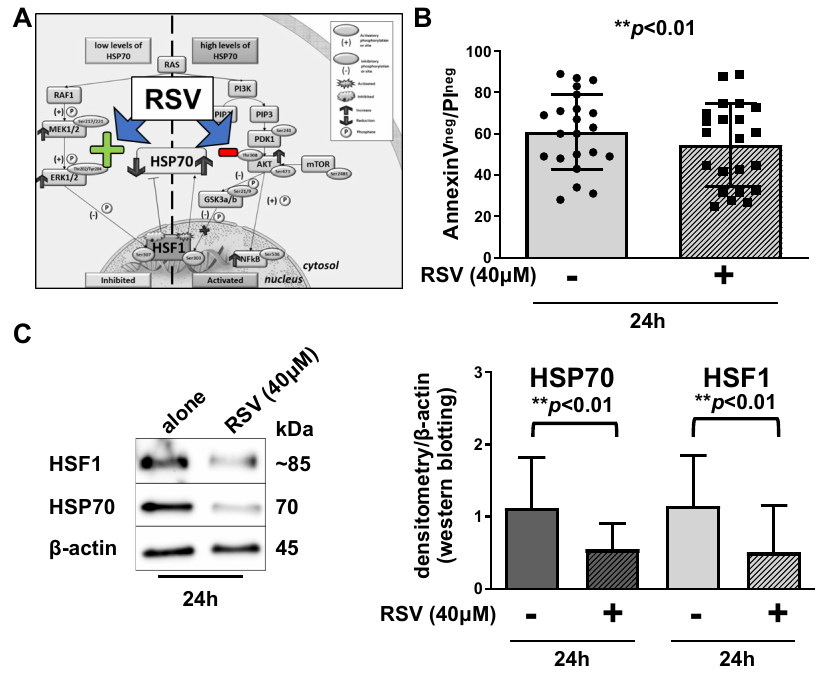
Figure 1. Resveratrol induces apoptosis in CLL leukemic B cells. ( A ) . The model explains HSP70 regulation by HSF1 via RAS-dependent pathways in CLL (adapted from 10) and RSV targets. In HSP70 high patients, we found an increased phosphorylation of AKT-Ser473 ( ↑ ) that is reflected in a high amount of GSK3a/b phosphorylated at inhibitory Ser21/9. In this way, GSK3a/b is no more able to inhibit HSF1 that, in turn, up-regulates HSP70 ( ↑ ). In HSP70 low patients, we found an up-regulation of the RAS-RAF-MEK1/2-ERK1/2 pathway; activated ERK at Thr202/Tyr204 ( ↑ ) can phosphorylate HSF1 at inhibitory Ser307, thus preventing HSP70 transcription ( ↓ ). RSV acts by inhibiting AKT (red minus) and by activating Erk (green plus). ( B ). Cells were cultured alone or in the presence of 40µM RSV, and cell apoptosis was analyzed by annexin V/PI flow cytometric test. Histograms report the percentage of Annexin V neg /PI neg cells after 24h treatment. Data are reported as mean±SD (** p < 0.01, paired Student’s t test; n = 22). ( C ) . Lysates obtained from CLL B cells cultured alone or with 40µM RSV were analyzed by immunostaining with anti-HSP70, anti-HSF1 and anti- β -Actin as loading control. Western blotting is representative of all the cases analyzed ( n = 11). Histograms represents the densitometry of HSP70/actin and HSF1/actin ratios of the 11 CLL samples analyzed (** p < 0.01, paired Student’s t test between the treated vs. the untreated condition). RSV: resveratrol. PI: propidium iodide.